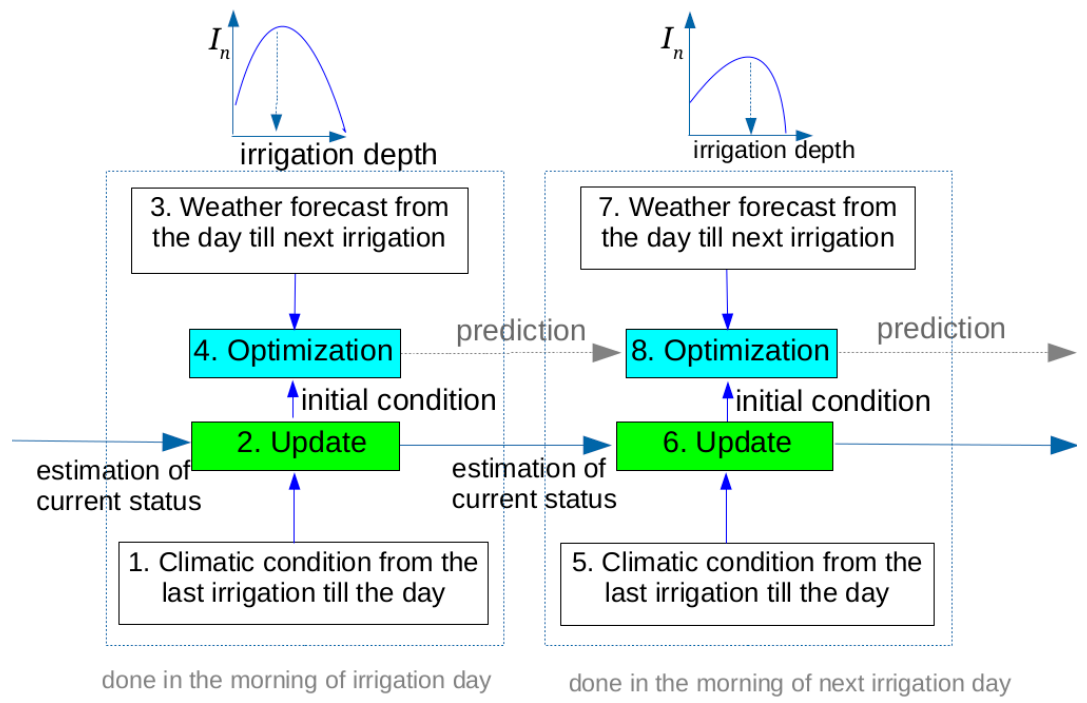
Figure 1. Schematic of the routine procedure of optimized irrigation (Numbers and arrows denote steps and data use, respectively).